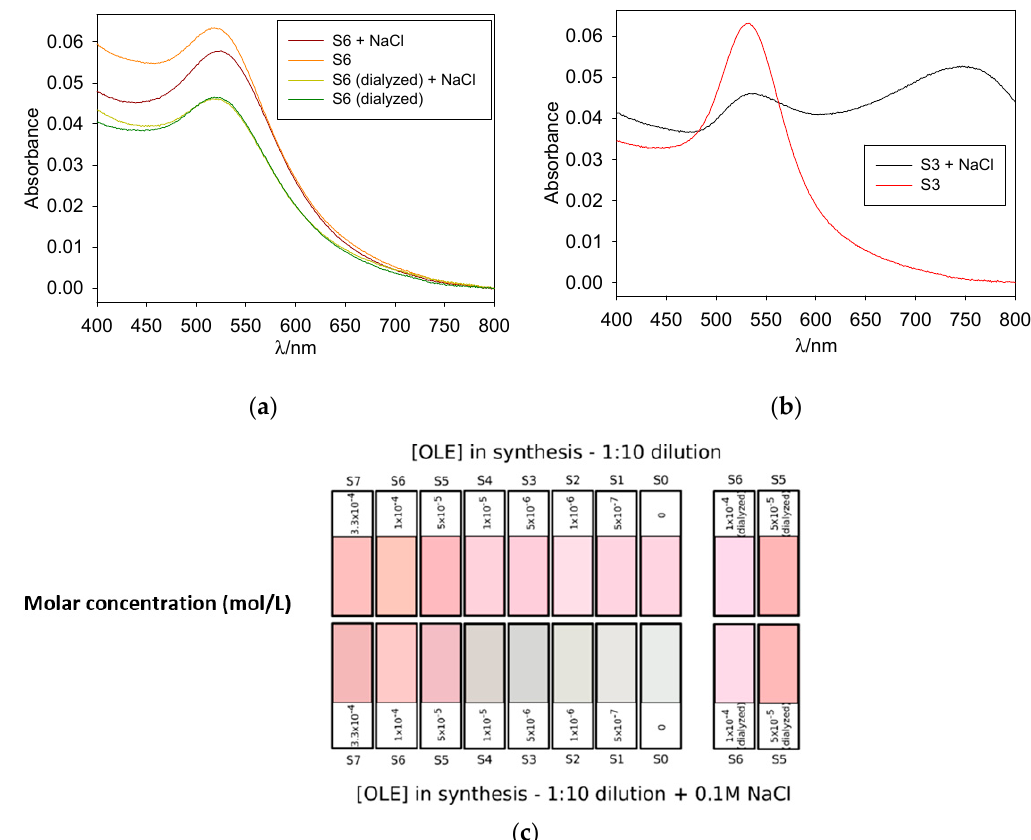
Figure 5. Normalized absorption spectra for 1:10 dilutions of samples S6 ( a ) and S3 ( b ) and RGB color simulation for all samples ( c ); upper row corresponds to diluted samples before NaCl addition and lower row to the same samples after an incubation period of 10 min with NaCl. Color intensity was enhanced for better perception.